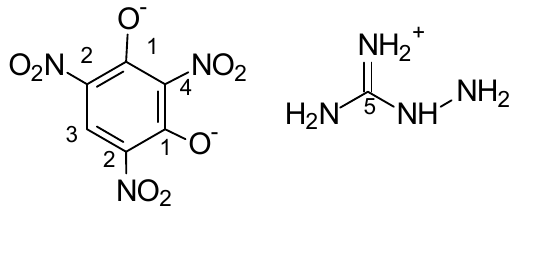
Figure 4. Numbering scheme of the carbon atoms in aminoguanidinium